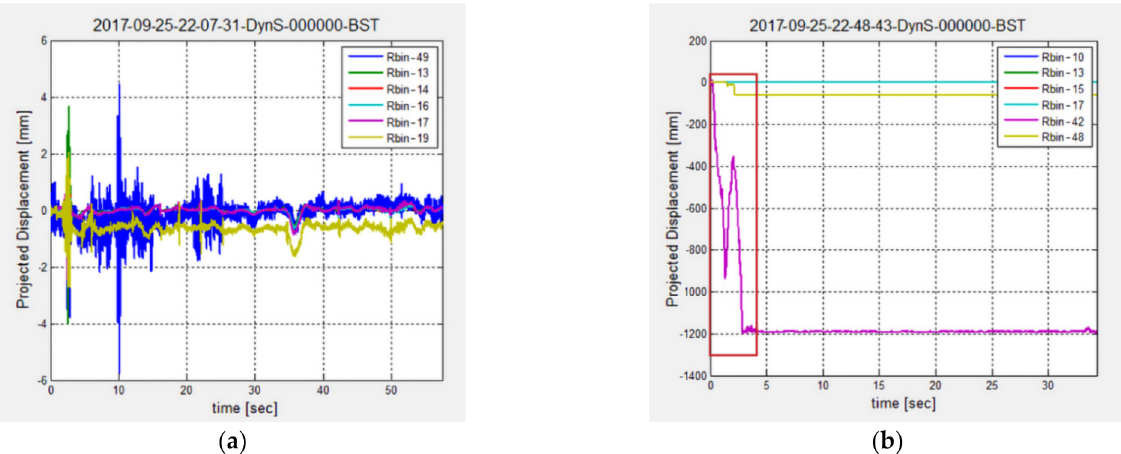
Figure 5. The acquired dynamic deflection of the Beishatan Bridge. ( a ) Dynamic deflection of the RSB and ( b ) dynamic deflection of the